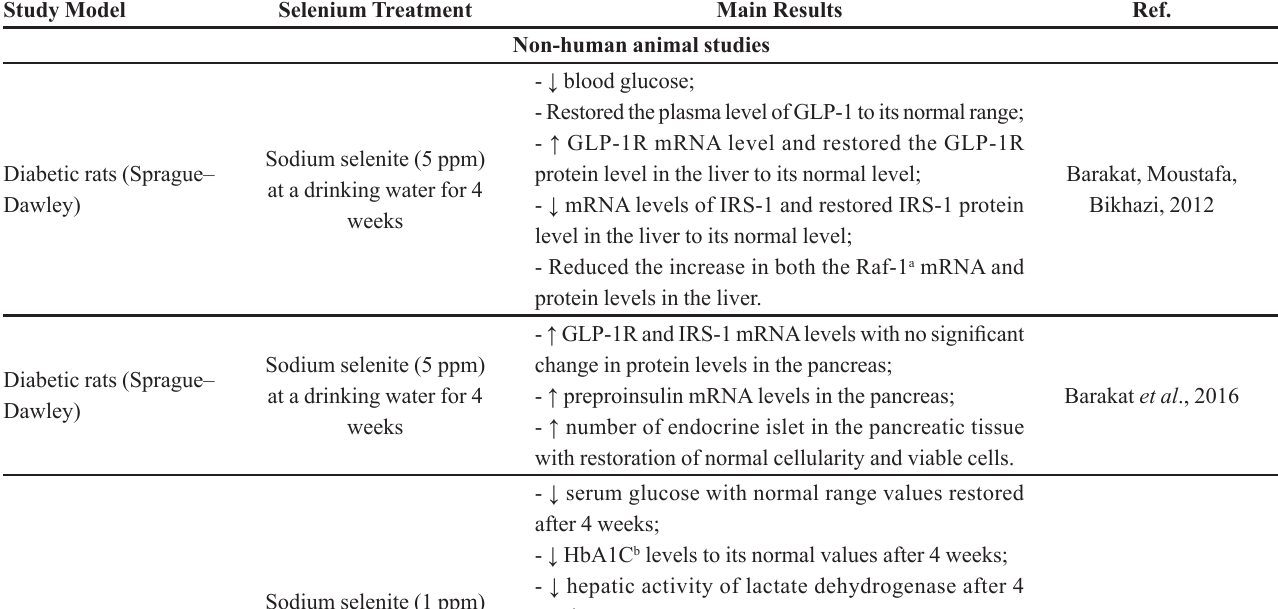
TABLE II - Selenium, glycemic parameters and insulin resistance: a summary of studies in cellular and non-human animal models Study